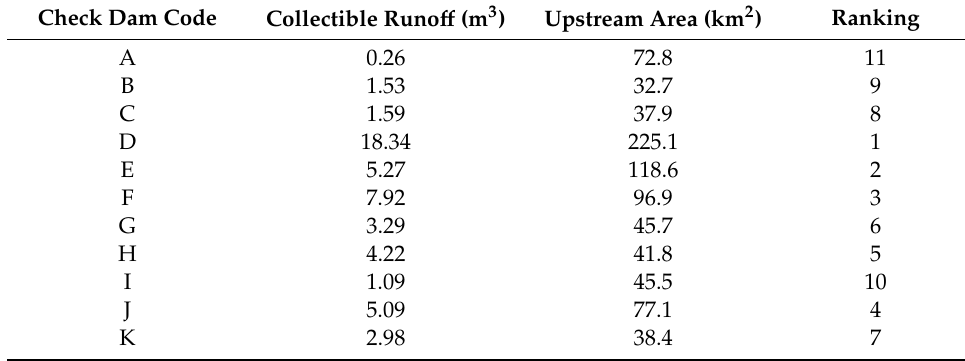
Table 4. Estimated amount of collectible water at each runo ff harvesting structure based on the quantity of generated runo ff from upstream